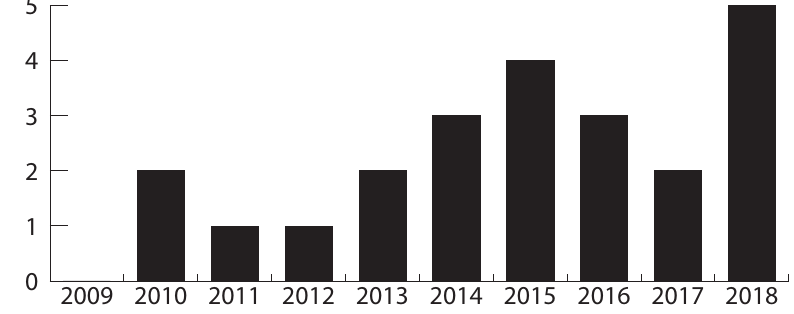
Figure 2. Frequency of publications per